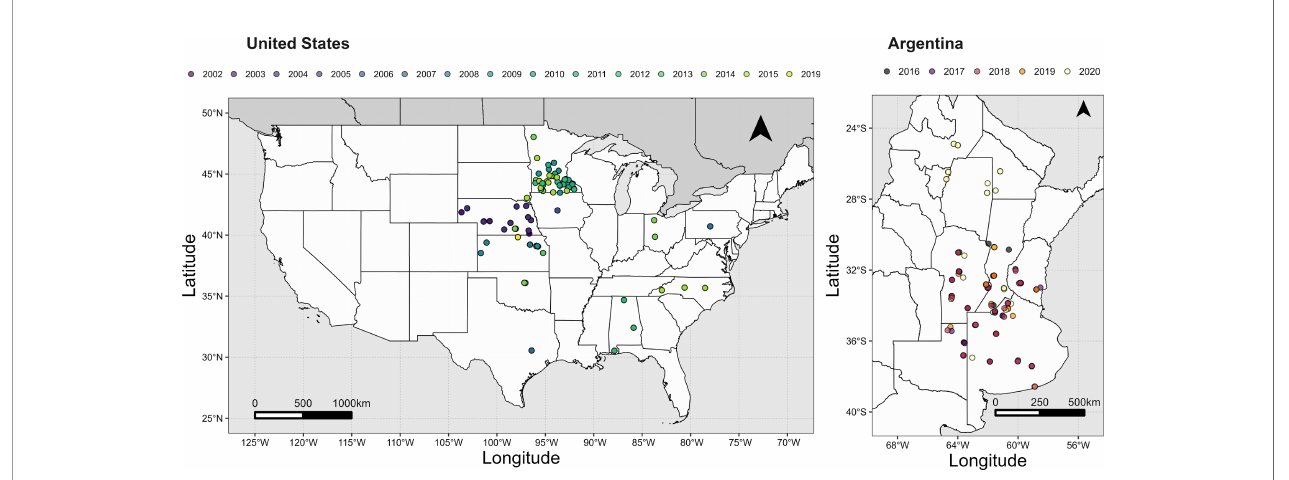
FIGURE 2 | Locations and seasons for maize trials in the US and